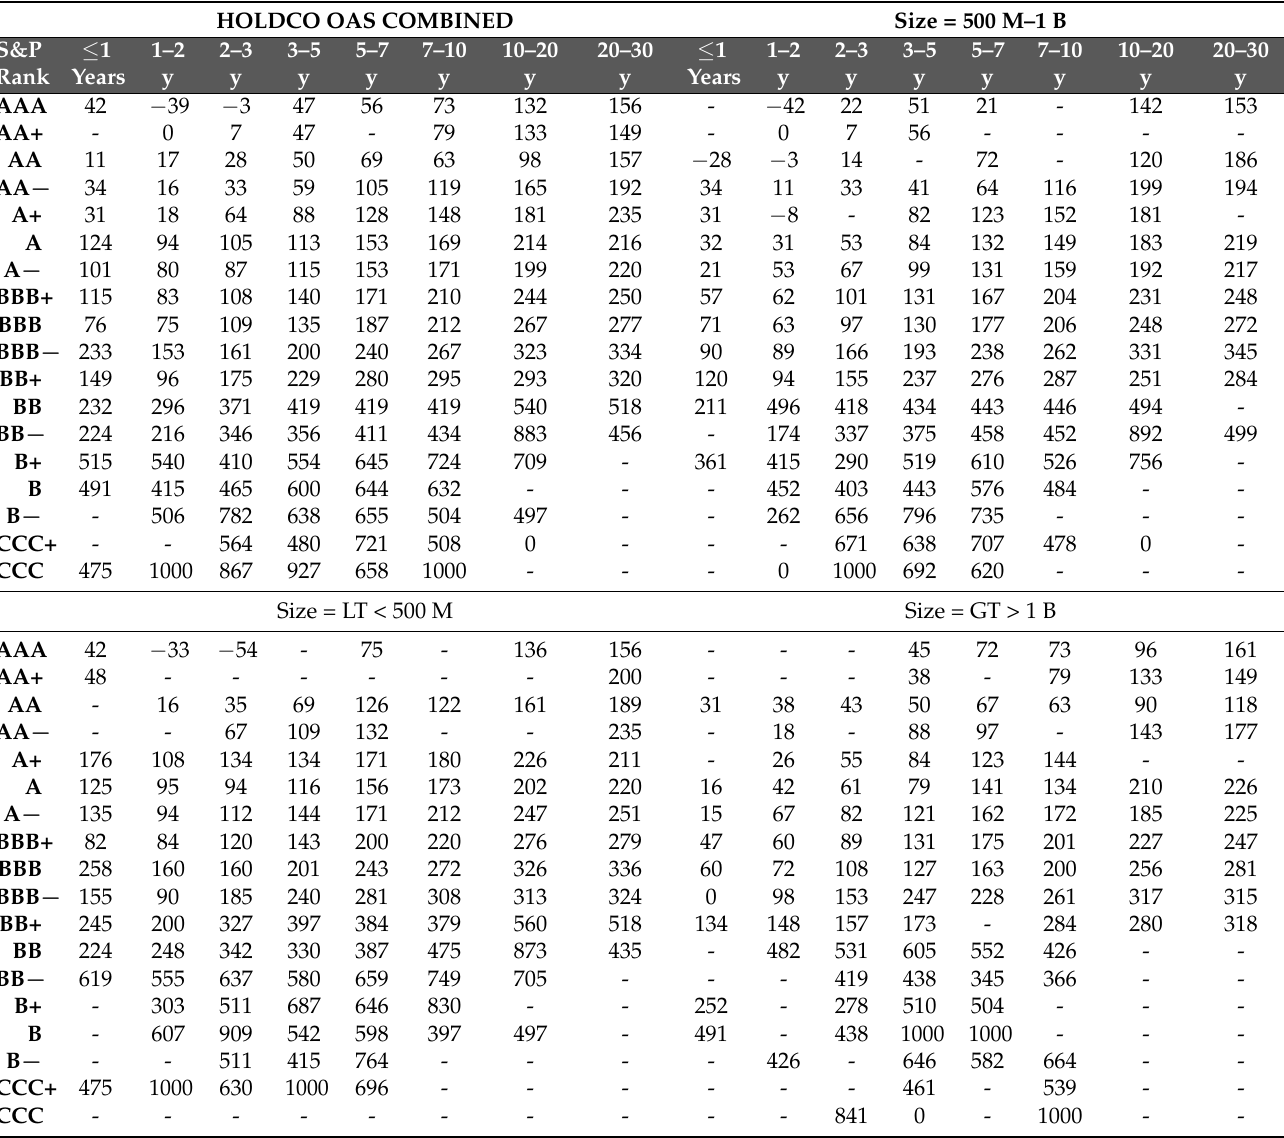
Table A2. Option-adjusted spreads for U.S. holding companies, using S&P ranking and matching Treasury maturities. Cell values are the average OAS in basis points for the bonds in the cell (computed using Bloomberg—Fixed Income Worksheets, accessed on 26 September